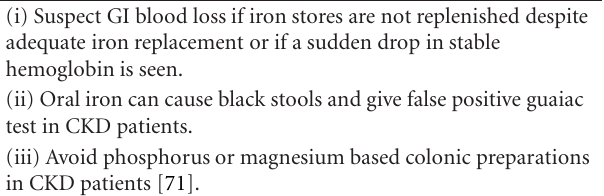
Table 1: Important facts about LGI bleed in CKD